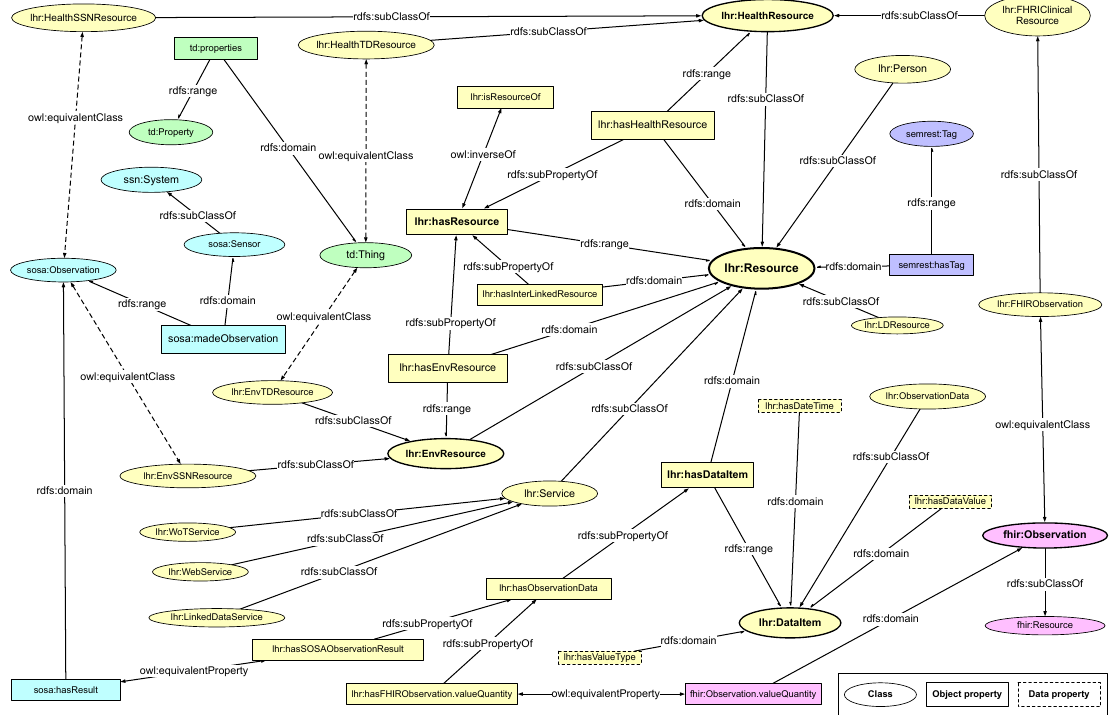
Figure 2. Linked Health Resource Ontology (with vital objects). The integrated health services, home environment devices and resources are modeled as sub-classes of the lhr:Resource class, which is the fundamental class in this ontology. Certain equivalent classes and properties are mapped to FHIR, SSN, SOSA, and WoT Thing Description for